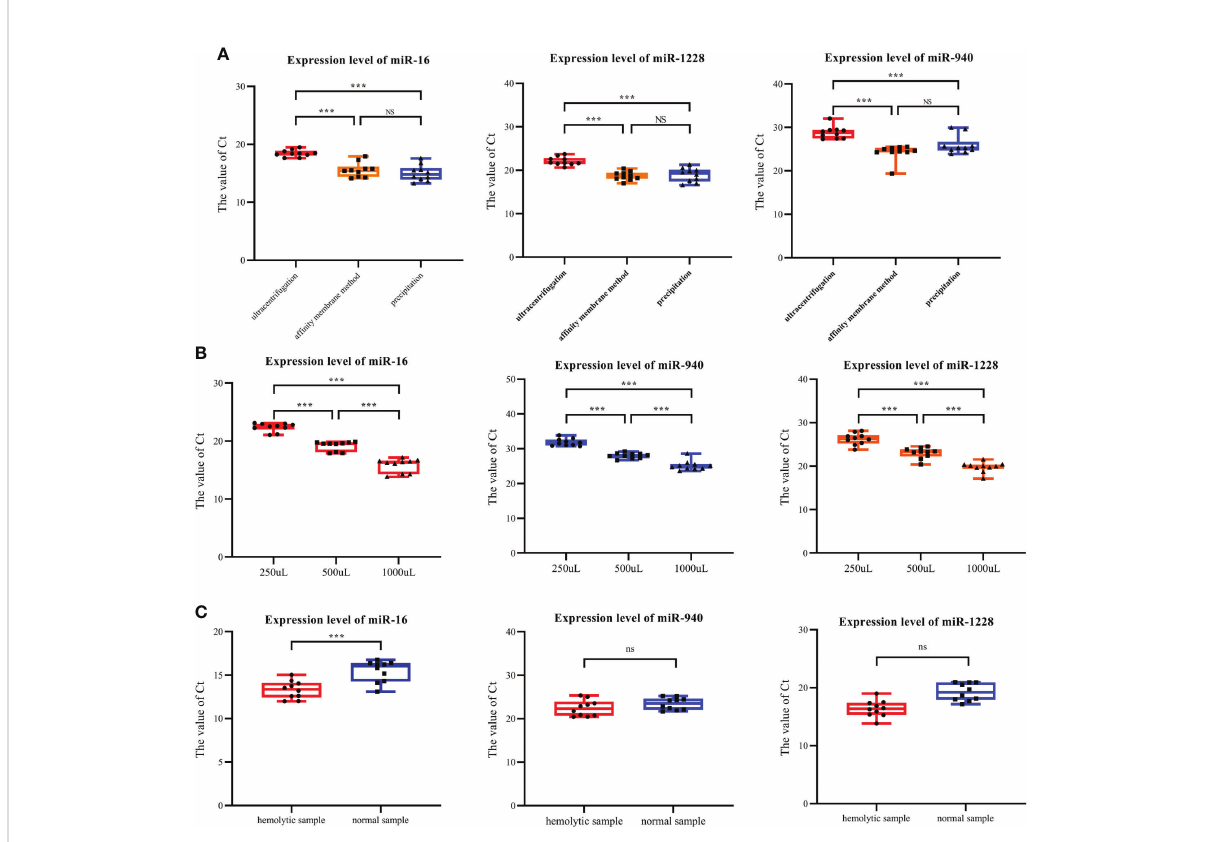
FIGURE 2 Expression levels of exosomal miR-940, miR-1228 and miR-16 under various conditions. (A) The three types of miRNAs were found at the lowest levels in the exosomes isolated by ultracentrifugation. (B) Three miRNAs were expressed in serum exosomes obtained with initial serum levels of 250, 500 and 1000 m L. (C) Expression of three exosome miRNAs in hemolysis and normal blood samples. (*p<0.05, **p<0.01, ***p<0.001, no signi fi cance, ns